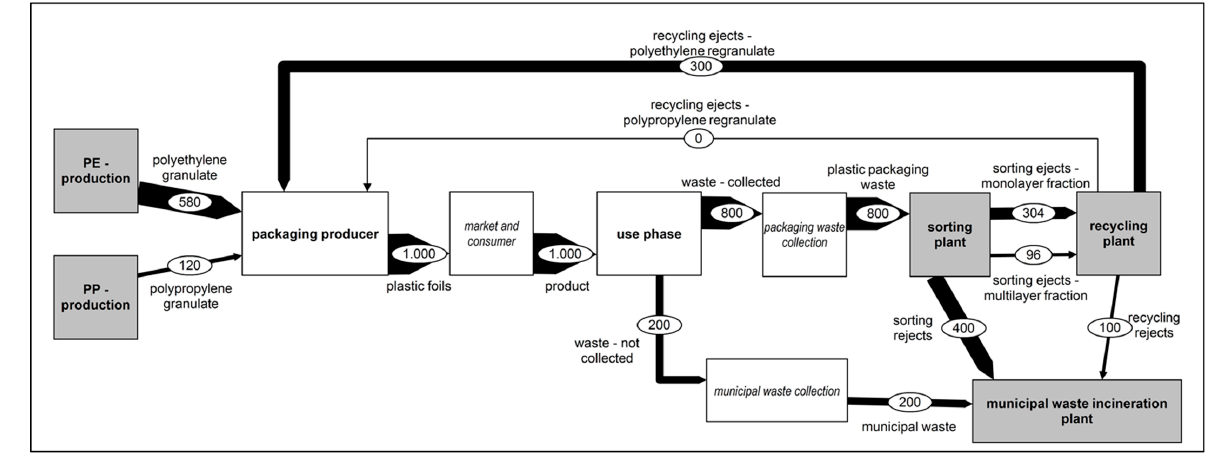
Figure A8. Material flows—Scenario 7—State Of the Art.